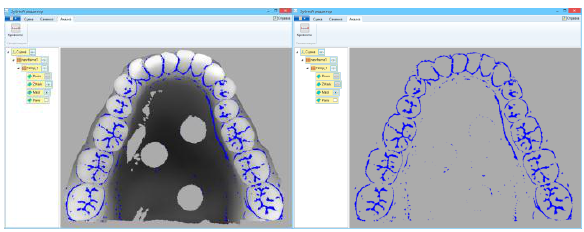
Figure 5. Results of dental arch 3D model